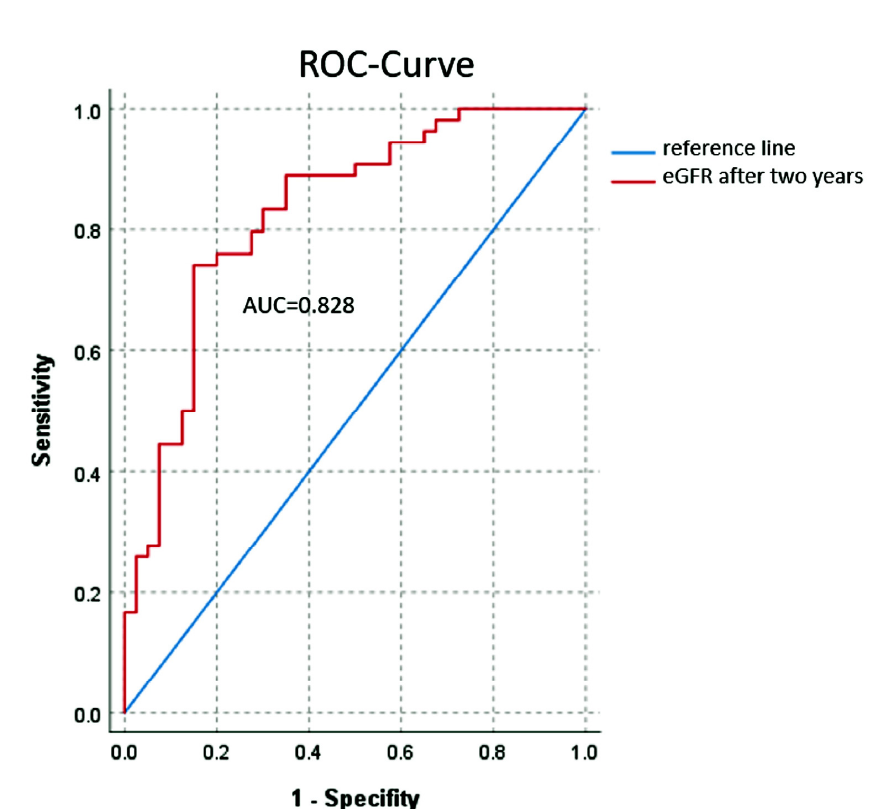
Figure 5. The GDF15 levels of recipients one year after KTx were significantly associated with the graft function at the same time ( A ) and also one year later (two years after KTx, ( B )). GDF15 levels < 1000 pg / ml one year after KTx predicted a better eGFR at two years after KTx ( C ). KTx: kidney transplantation.